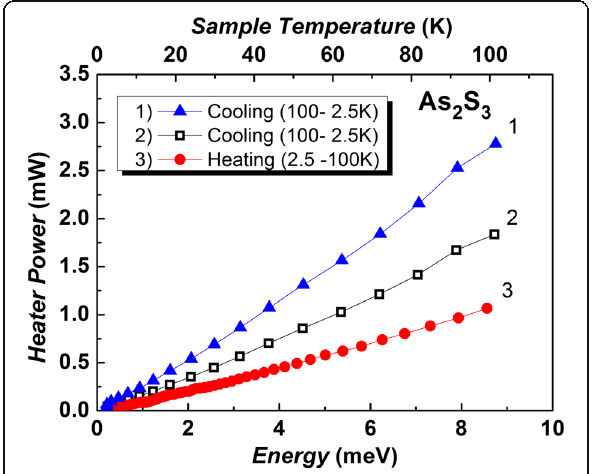
Fig. 1 The heater power changes during the measurement processes (heating and cooling of g-As 2 S 3 ) (see details in the inset ). ( Color online